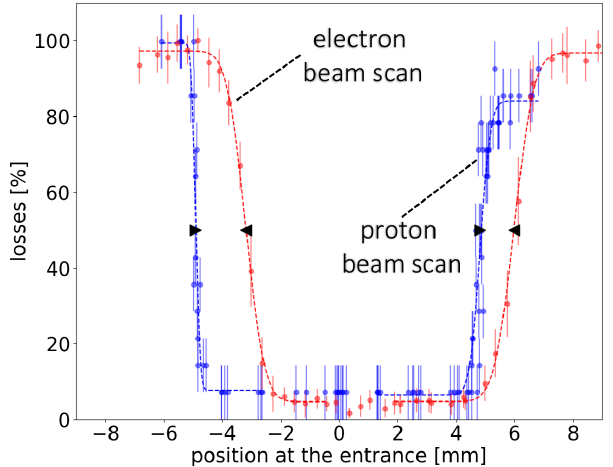
FIG. 4. Proton (blue dots) and electron (red dots) beam losses as a function of the horizontal position at the vapor source entrance aperture. Dashed lines are the error function fits, the black triangles the centers of the rising